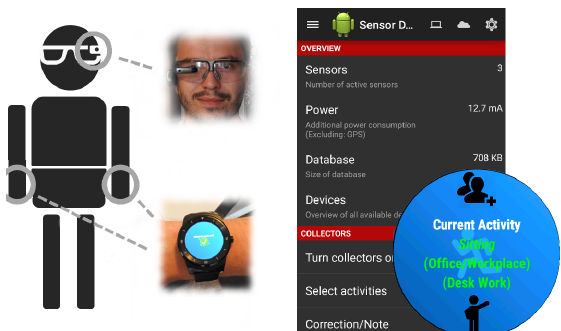
Figure 3. Sensor data collector application. The application is able to record a big set of sensors in Android devices including inertial data, temperature, and audio for example.